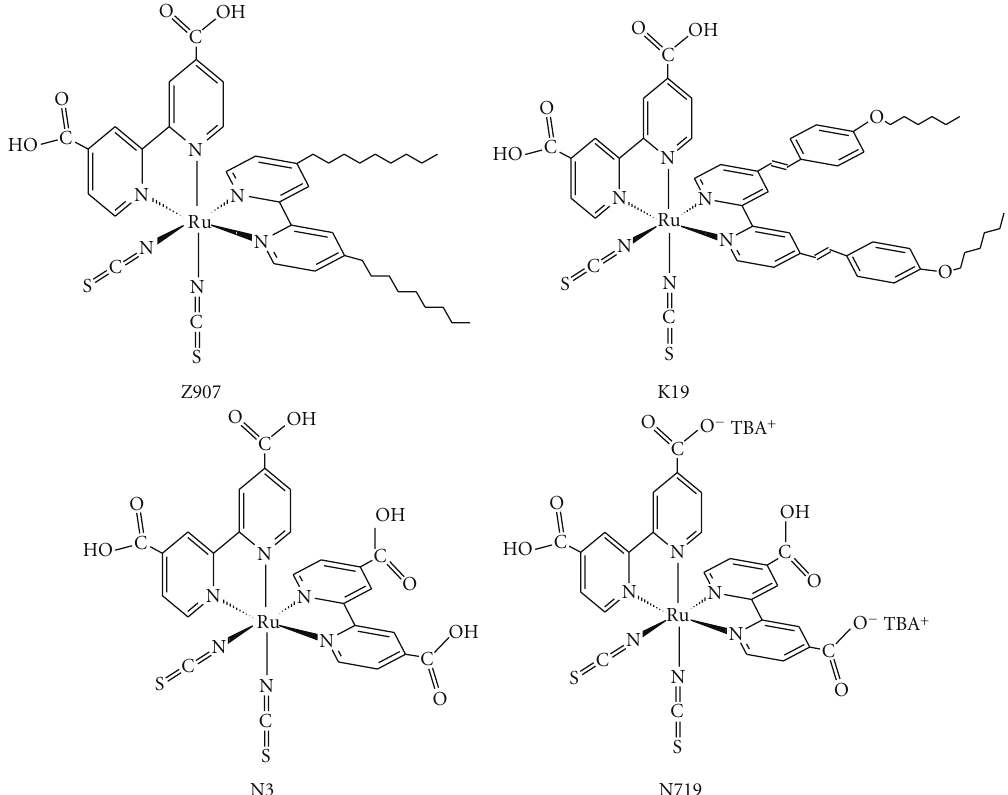
Figure 2: Structure of some of the most successful polypyridine Ru(II) dye based on the NCS ancillary ligand.